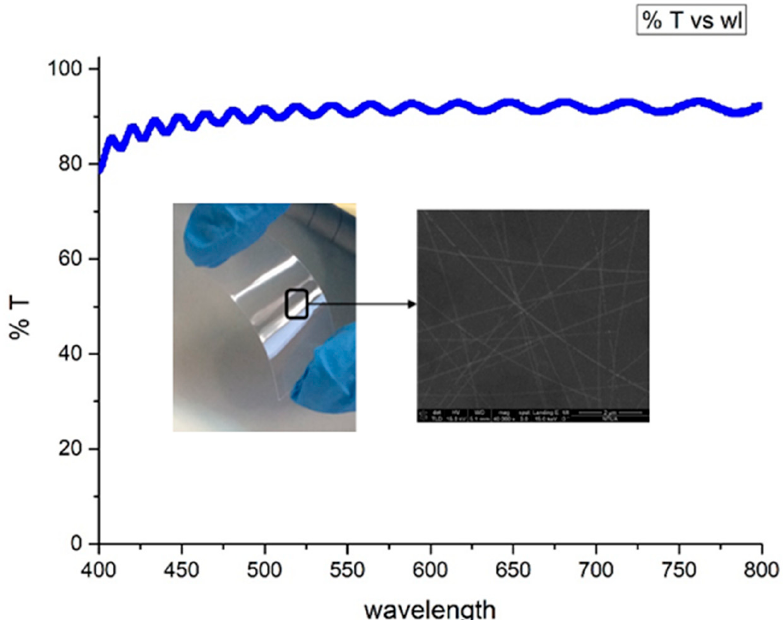
Figure 2. Transmittance vs wavelength for 106 Ohm/sq Ag NW network. Total visible light transmission is over 90% on PEN substrate and T at 532 nm is 91.6% on PEN.